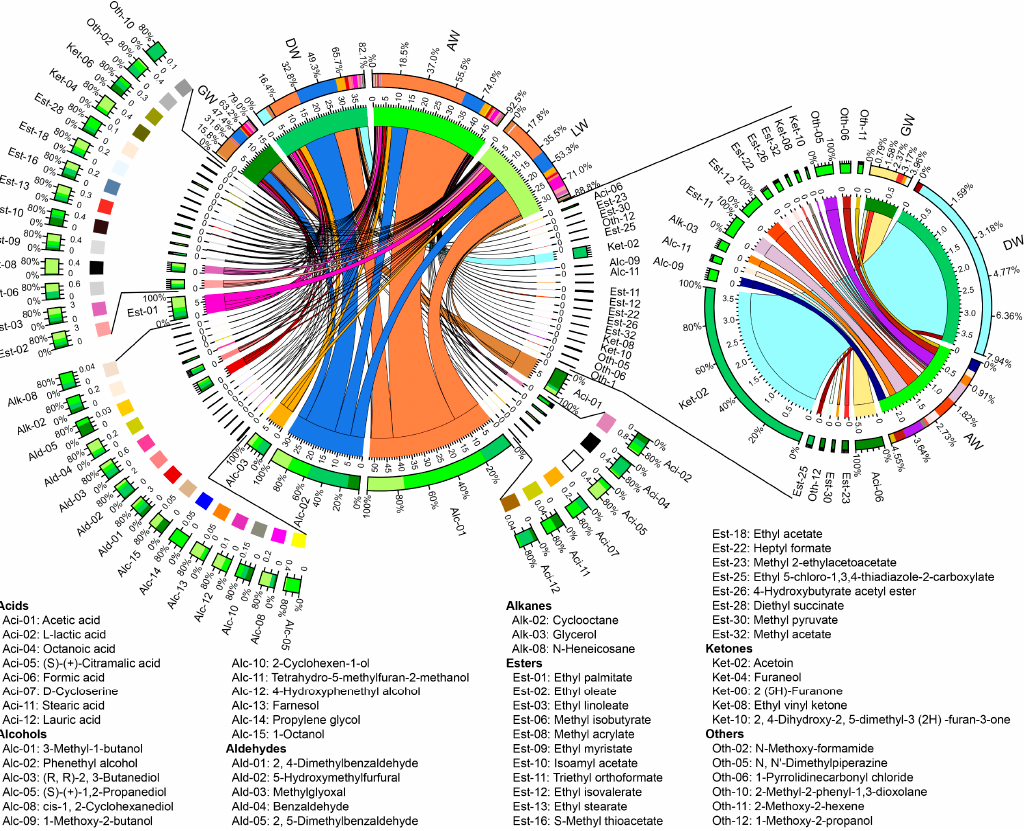
Figure 6. Distribution of the 58 important volatile compounds for each rice wine sample. The width of the bars from each compound indicates the distribution ratio of that compound in the sample. The unit of the inner ring is mg/L.